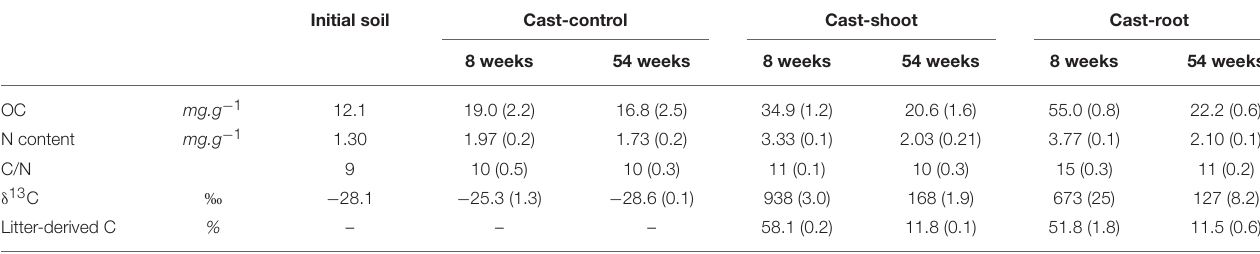
TABLE 1 | Characteristics of initial soil, as well as Cast-Control, Cast-Root and Cast-Shoot samples over time, before fractionation in POM and MOM (numbers in parentheses indicate the standard deviation, n = 3). Initial soil Cast-control Cast-shoot